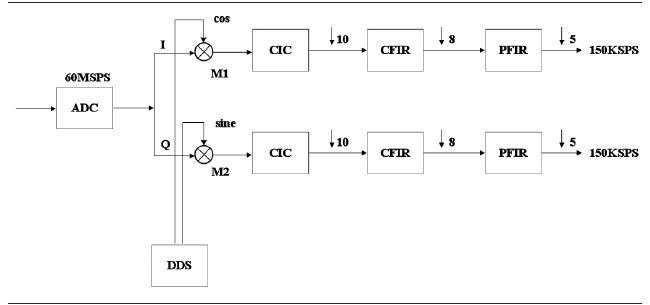
Figure 4. Block diagram of the DDC in the receiving